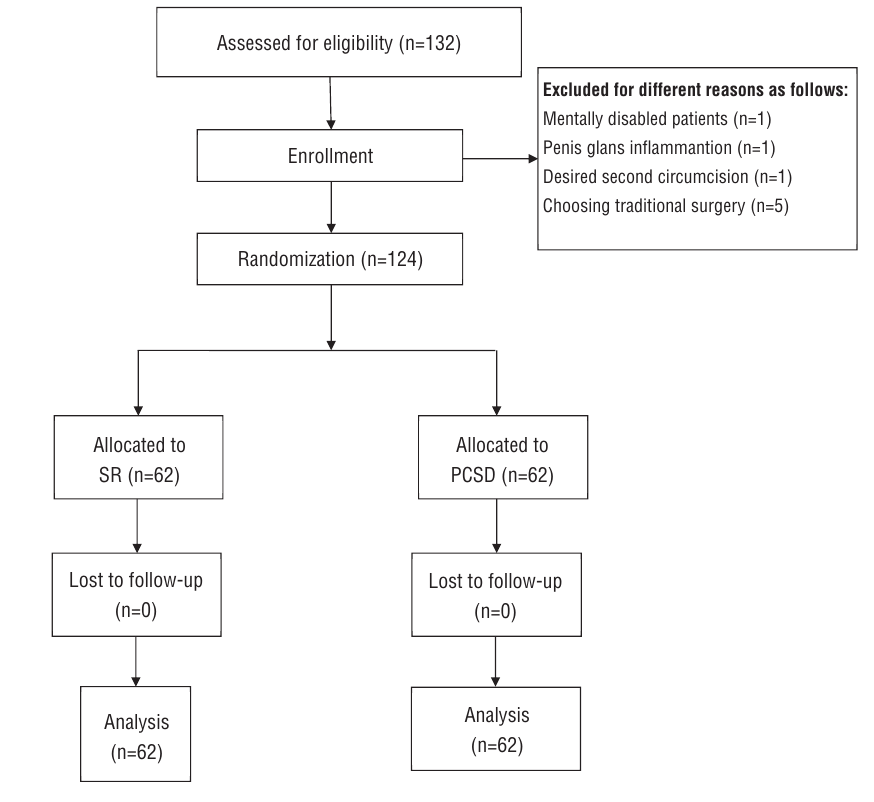
figure 1 - consort